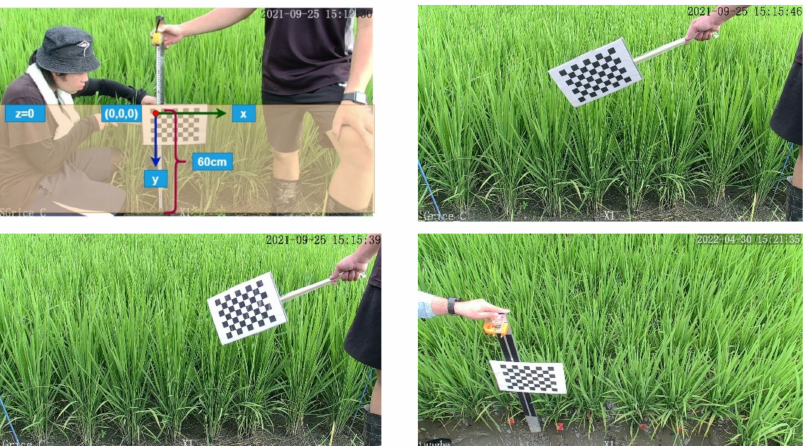
Figure 6. Demonstration of Camera Calibration Using a Chessboard and Different Viewpoints Captured.